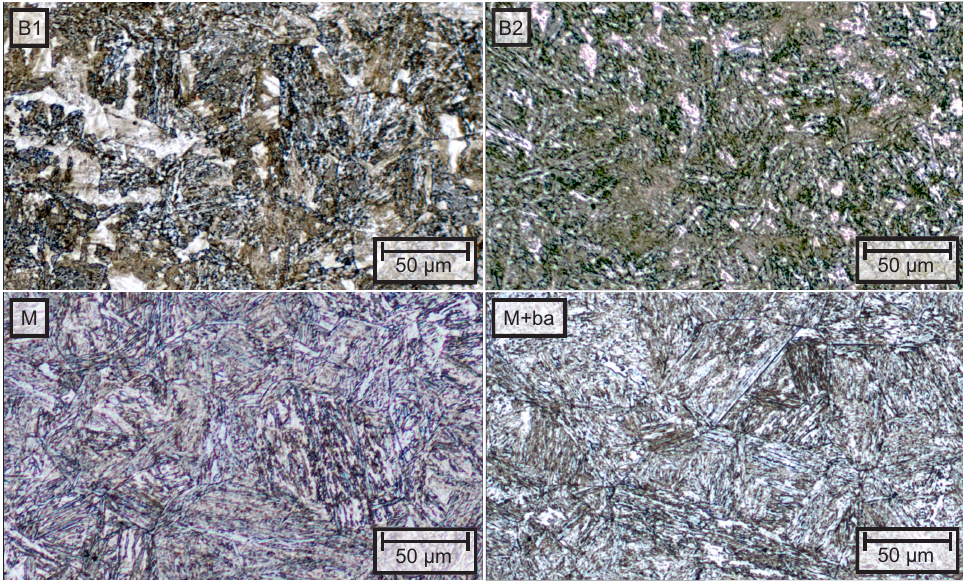
Figure 2. Microstructure of the bainitic steel grades (B1 and B2) as well as the martensitic steel in the as-forged condition (M) and in the annealed condition (M + ba).